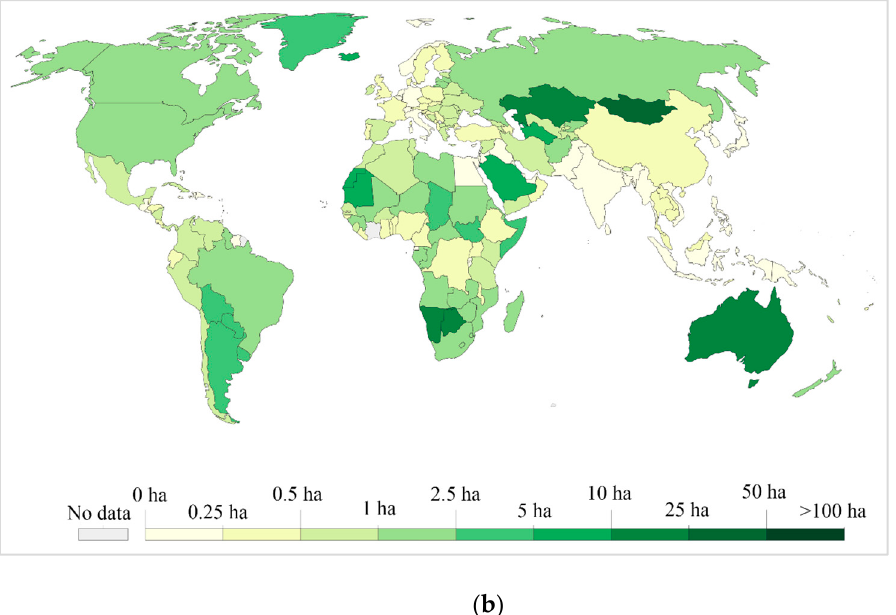
Figure 18. ( a ) Agricultural land per capita by continent, 2009–2018 (Note: Oceania is not shown in Figure 18a due to its large agricultural area combined with its tiny population). Date from ref. [104,105]. Copyright 2021 Land Use and FAO; ( b ) global agricultural land per capita in 2018. Date from references [104,105] . Copyright 2021 Land Use and FAO.